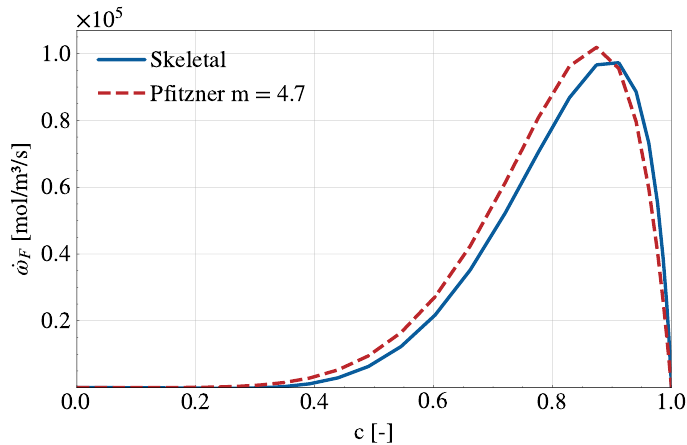
Figure 17. DNS fuel reaction rates for skeletal and Pfitzner chemistry vs. progress variable in a 1D laminar flame.